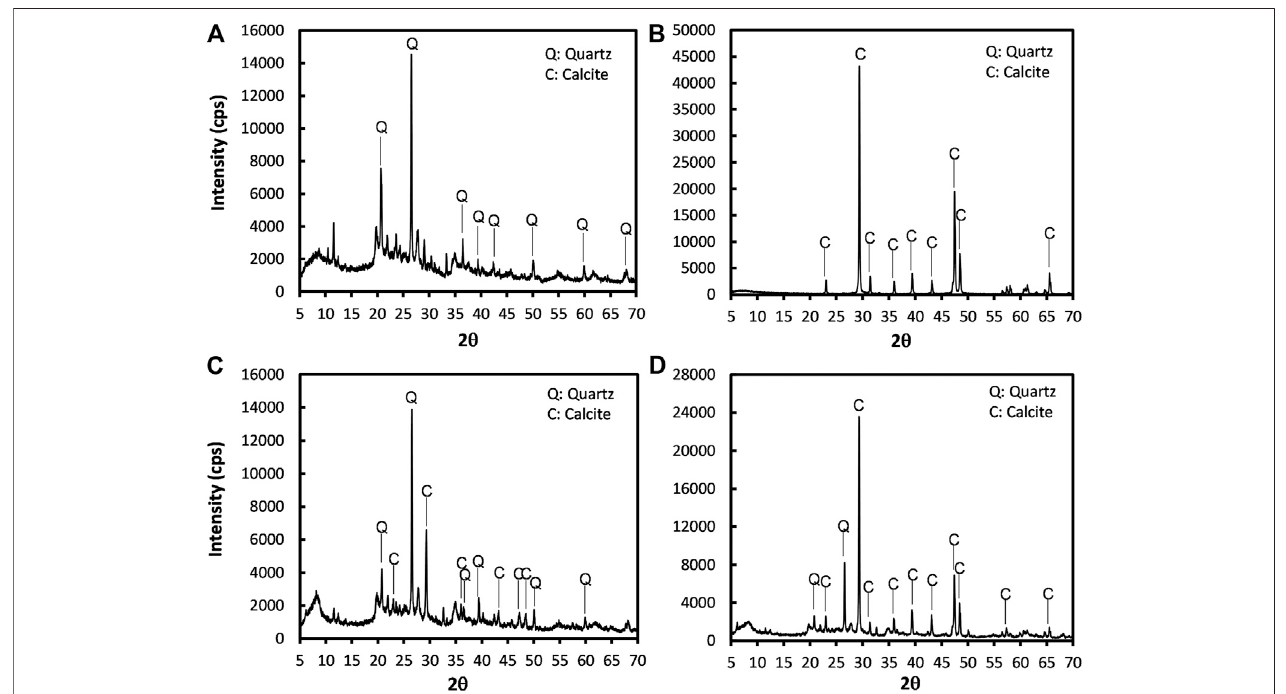
FIGURE 12 | Representative XRD analysis of the mineralogical characterization of the (A) raw peat, (B) SSP, (C) MICP-treated amorphous peat, and (D) MICP + SSP treated amorphous peat.